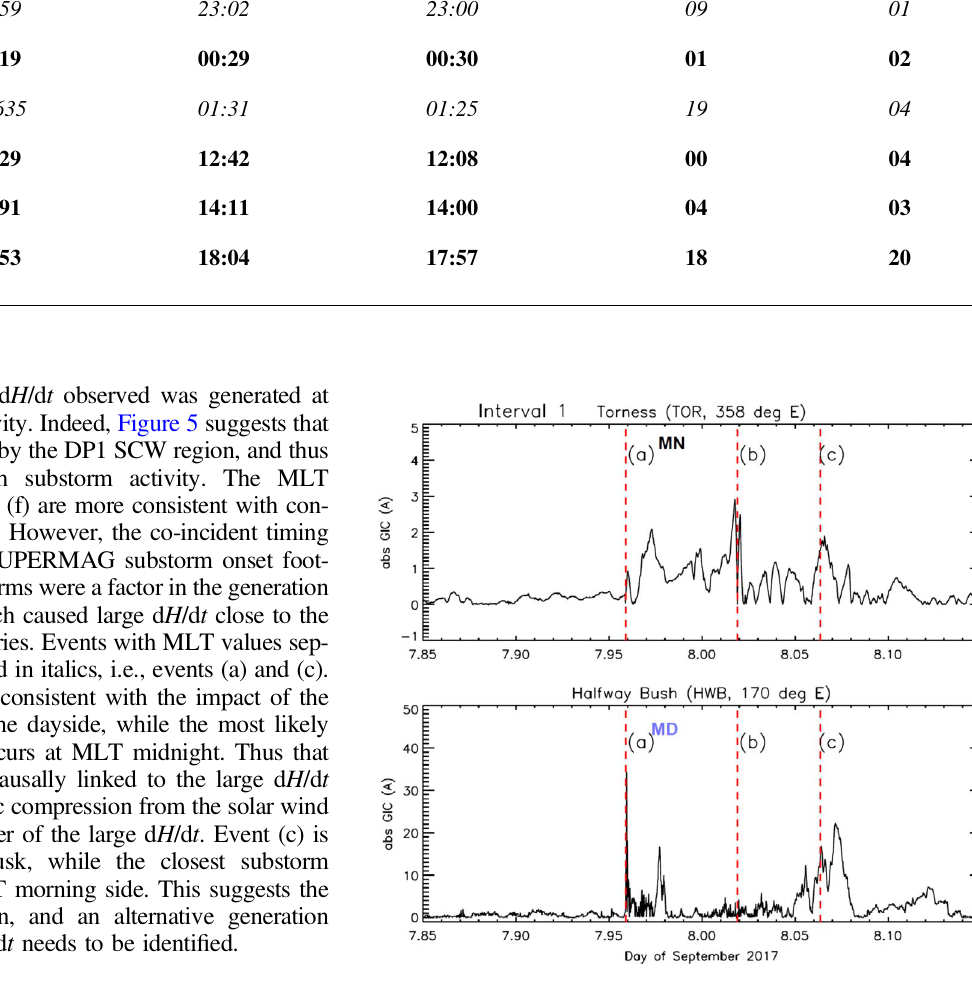
Fig. 6. Mid-latitude magnitude GIC data from Scotland (Torness) and New Zealand (Halfway Bush) during Interval 1 on 7 – 8 September 2017. The times of coincident, large d H /d t events (a) – (c), determined from Figures 3 and 4, are plotted as vertical red dotted lines where they coincide with enhanced GIC levels. The times of local magnetic midnight (MN) and midday (MD) are shown on the panels. Note the factor of 10 difference in the y -axis